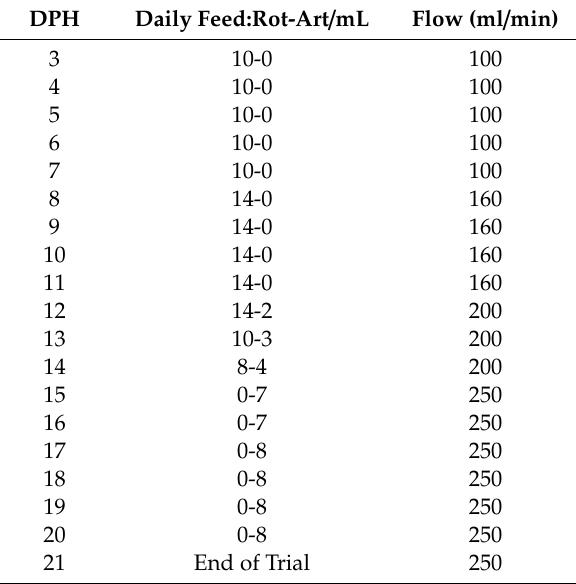
Table 1. Experiment husbandry schedule. Amount of daily feed o ff ered, and recirculation flow changes with time are shown. DPH Daily Feed:Rot-Art / mL Flow (ml /